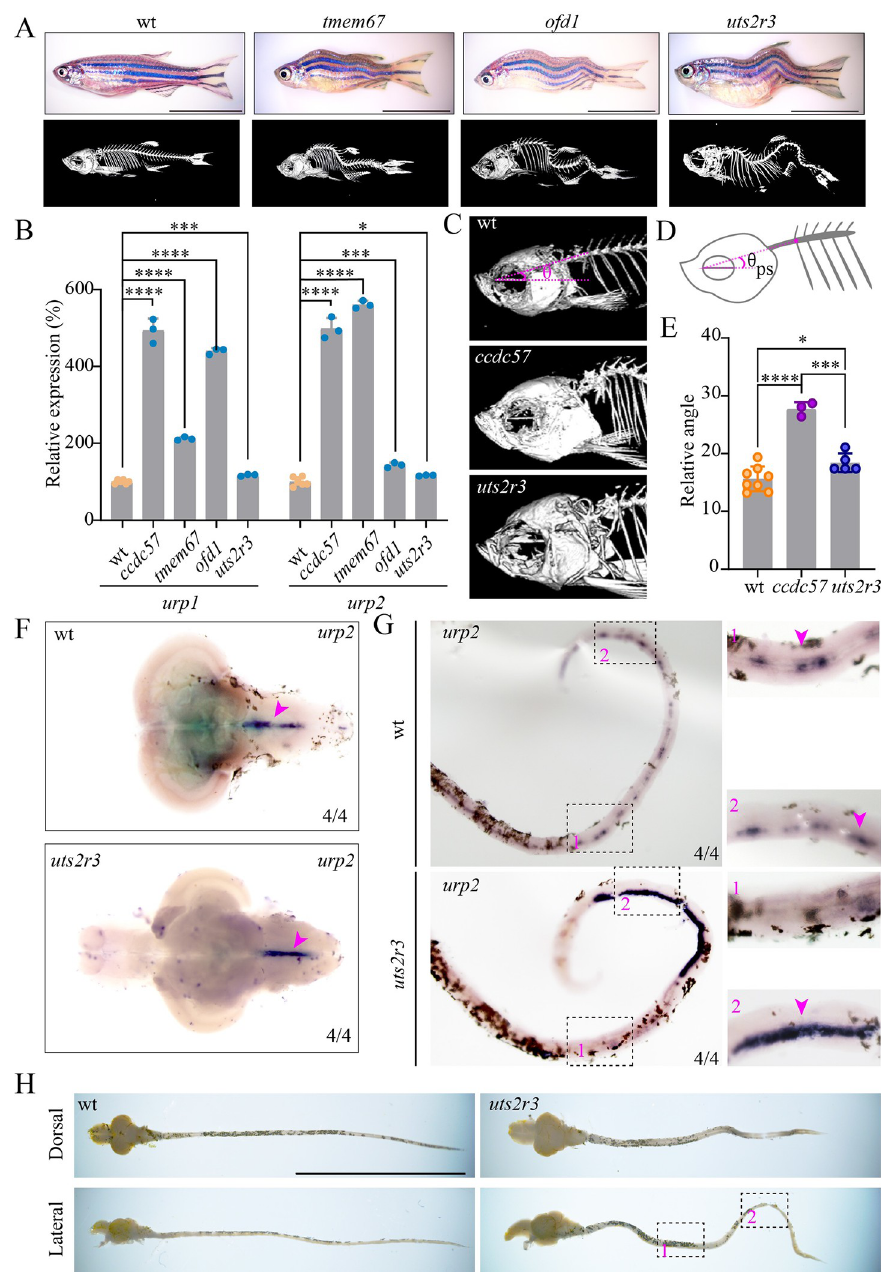
Fig 8. Ectopic accumulation of urotensin neuropeptides is associated with spine curvature in zebrafish ciliary mutants. ( A ) Representative images of wild type and scoliosis zebrafish mutants. Micro-CT images are shown on the bottom. ( B ) qPCR analysis showing the expression of urotensin genes in the heads of wild type and scoliosis mutants. ( C ) Enlarged views of the head regions of wild type, ccdc57 , and uts2r3 mutants. ( D , E ) Statistical analysis of the dorsal curvature angles in different mutants as indicated. The angles were measured between the direction of the parasphenoid bone and the Weberian vertebrae as illustrated in the diagram ( D ). ( F ) In situ hybridization results showing the expression of urp2 in the brains of wild type and uts2r3 mutant as indicated. ( G ) Expression of urp2 in the spinal cords of wild type and uts2r3 mutant. The strongly increased expression of the urp2 in the tail region was shown on the enlarged views. ( H ) Dissected spinal cords from wild type and uts2r3 mutants as indicated. The two boxed regions correspond to those in panel G. Scale bars: 1 cm in panels A and H. The data underlying the graphs shown in the figure can be found in S1